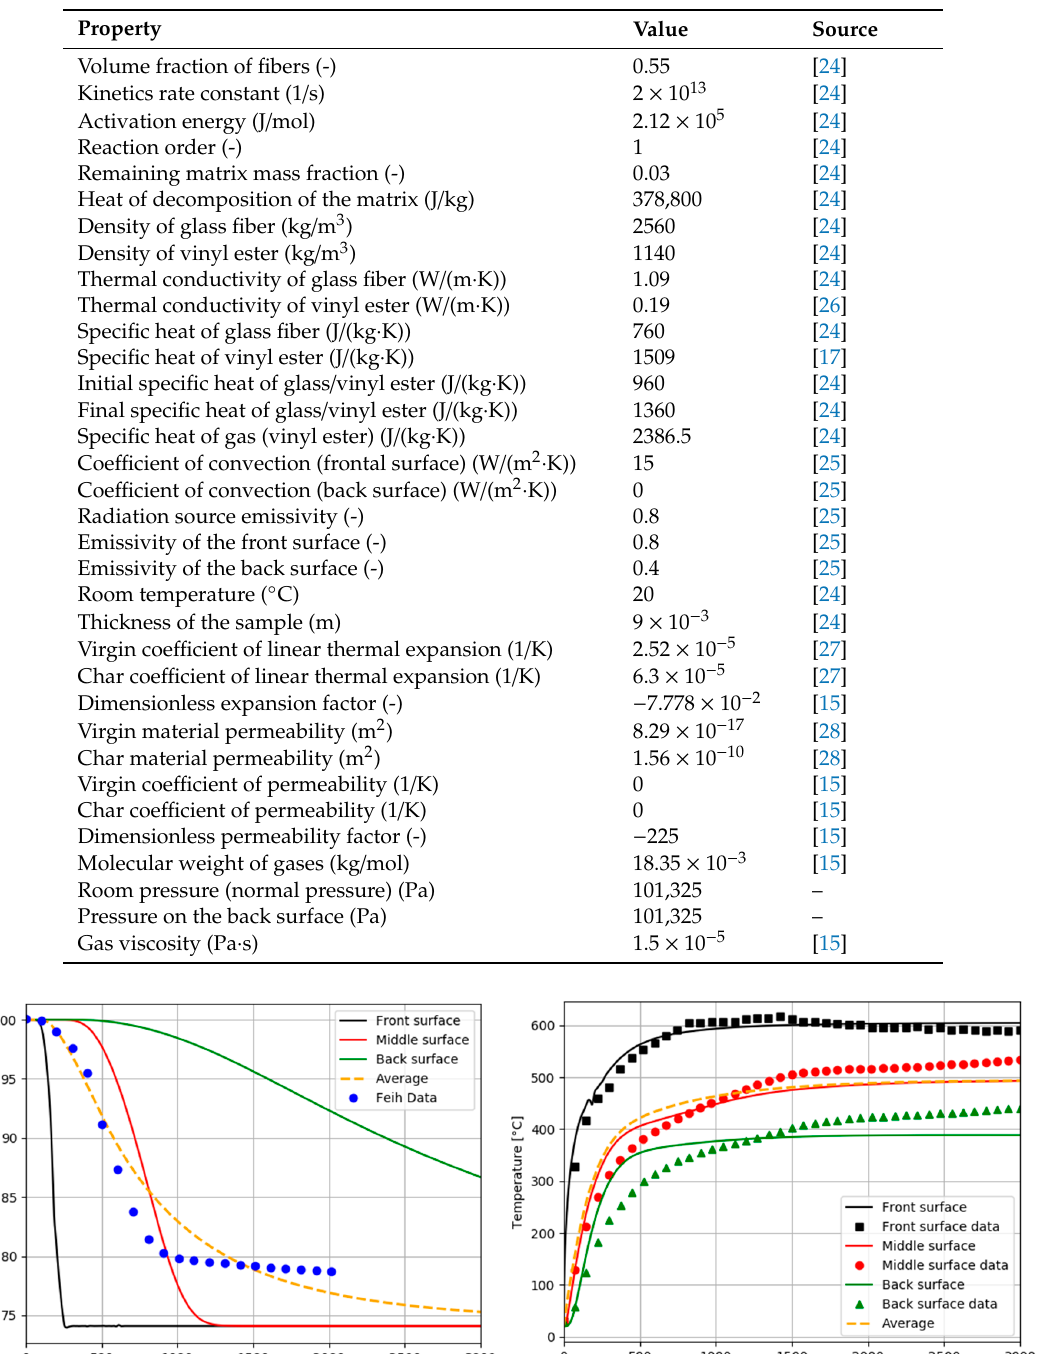
Table 1. Material Properties for E-glass / vinyl ester composite laminate.